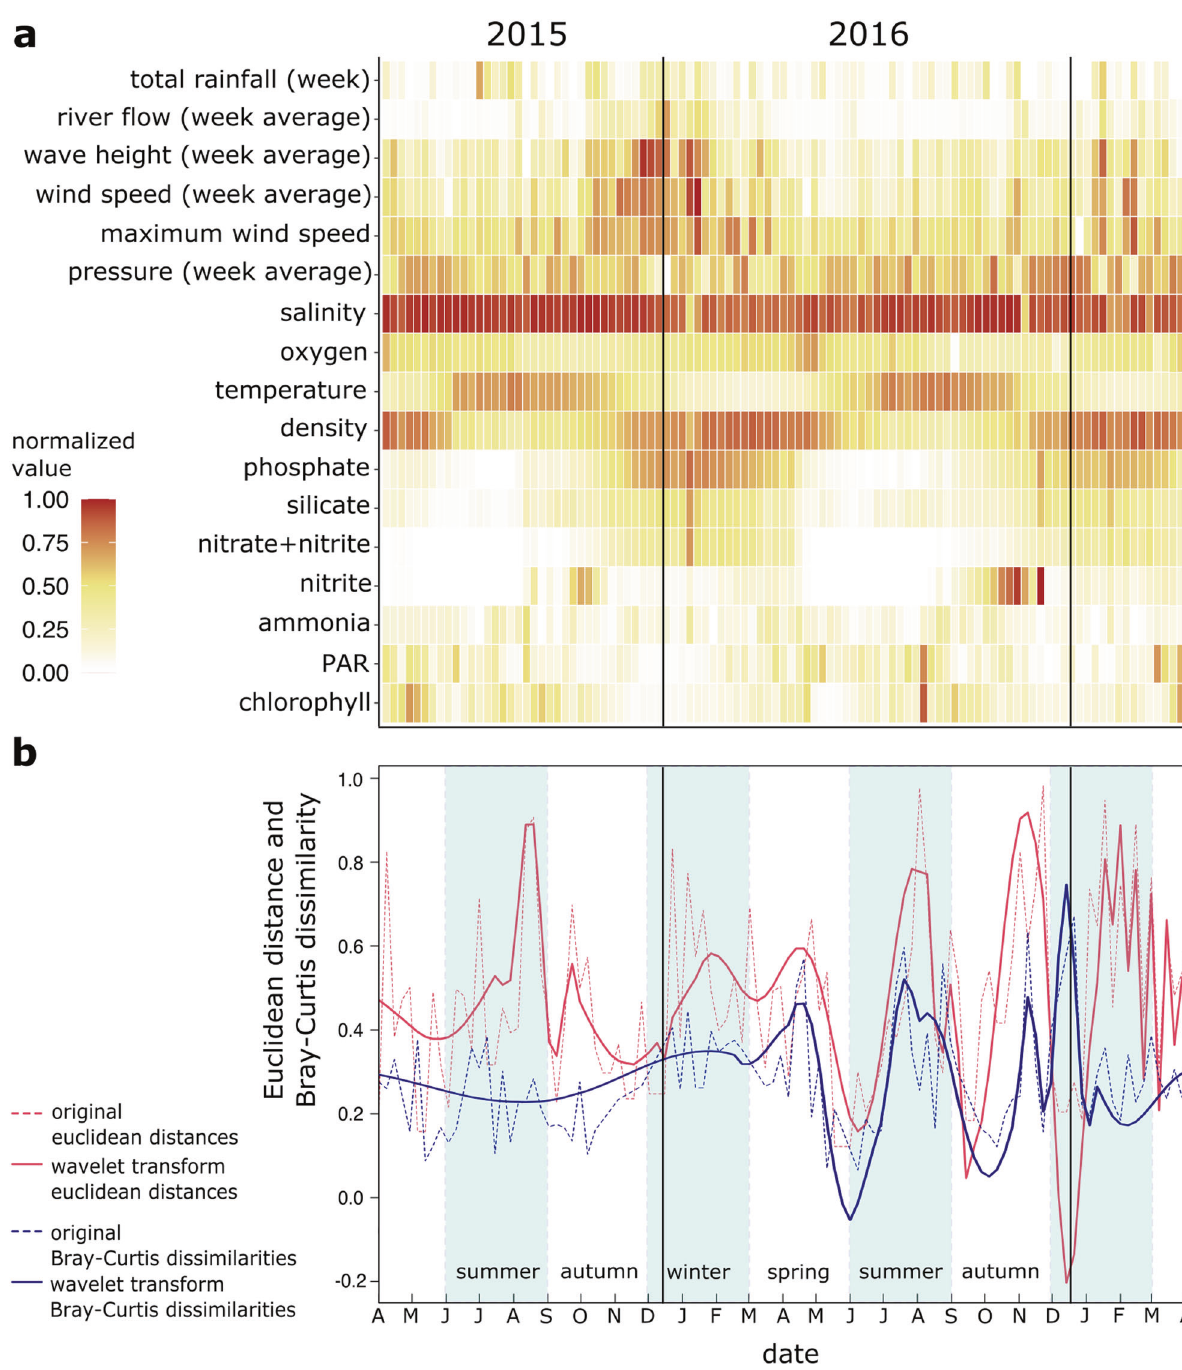
Fig. 6 Response of SAR11 community to environmental heterogeneity on a weekly scale at the Western English Channel. a Normalized values (0 – 1) of the 17 weather and oceanographic environmental parameters used to estimate the Euclidean distance between weekly consecutive samples. b Wavelet transforms (solid red line) of the weekly consecutive Euclidean distances representing the environmental changes and Bray – Curtis dissimilarities of the SAR11 populations (solid blue line). The original Euclidean distances and Bray-Curtis dissimilarities are shown as dashed lines, red and blue respectively. a and b These are aligned in the x -axis to represent the same week